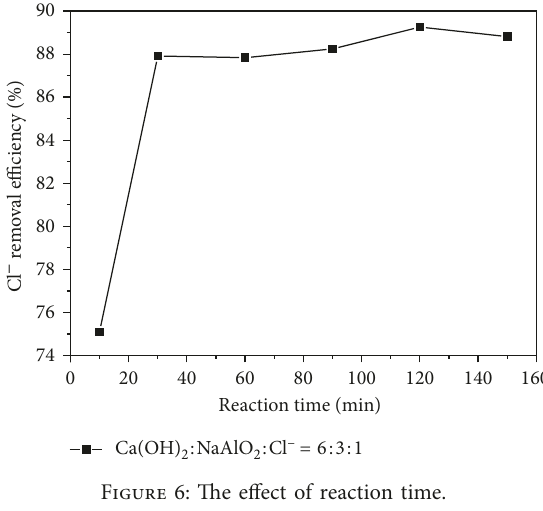
Figure 8: The effect of SO 42